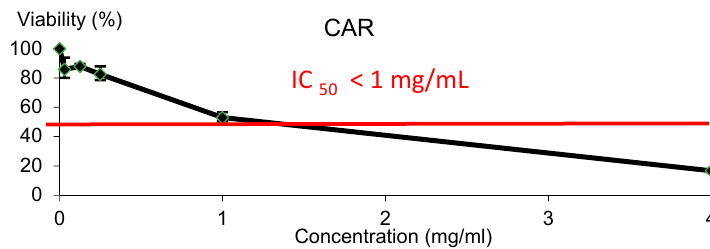
Figure 2. Viability of HL-60 cells treated with CAR for 72 h. Each point represents the percentage of viability with respect to the mean control ± SD of three independent experiments.